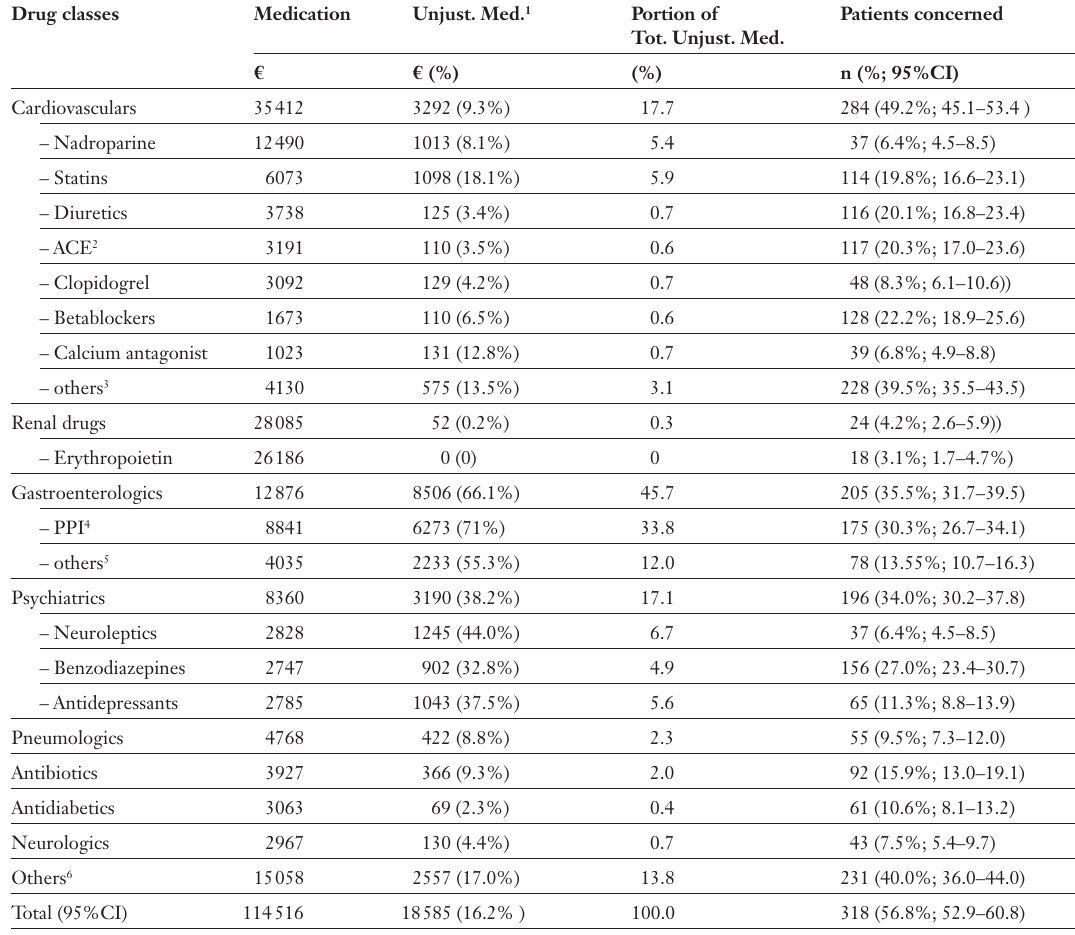
Monthly costs of discharge medica- tions from 318 pa- tients according to drug classes and justification of med- ication. Data are expressed in €.